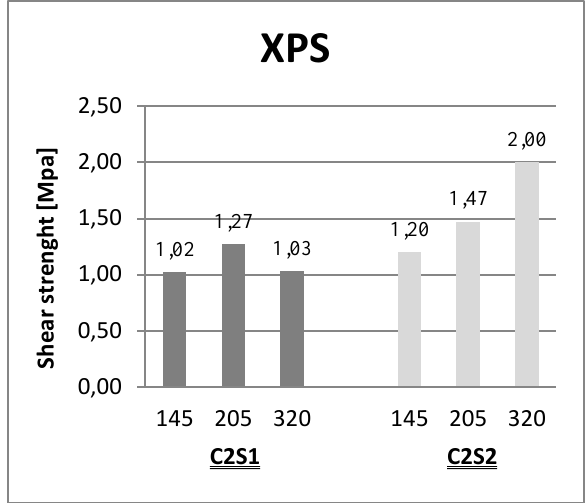
Figure 9: Average results of the pull-off method; comparing the same adhesive C2S2 to different mesh & insulation